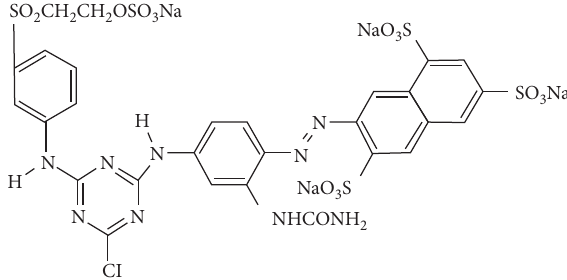
Figure 1: Structure composition of reactive yellow 145 (RY145)